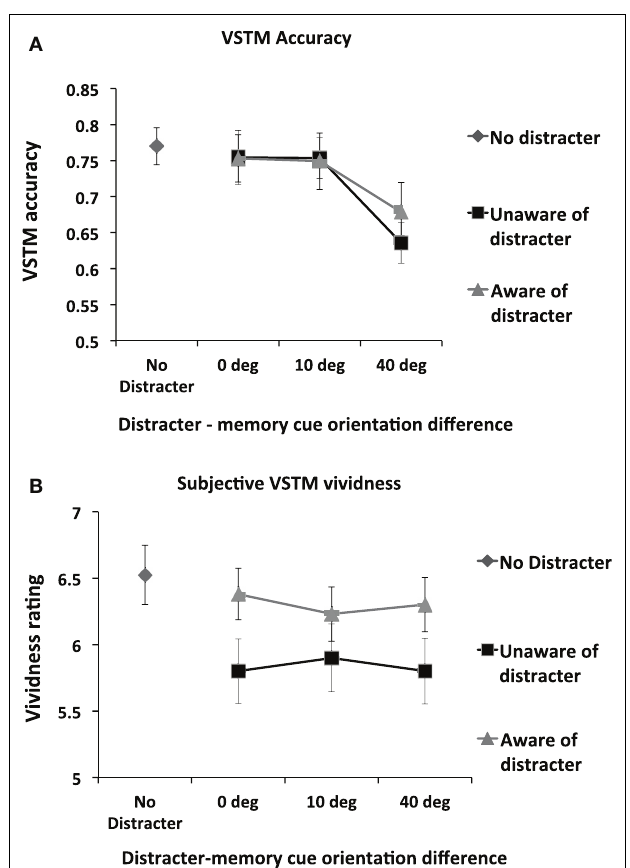
FIGURE 3 | (A) Mean ( n = 14) objective memory accuracy in theVSTM task as a function of the distracter orientation and visibility.The impact of the visual distracter onVSTM accuracy was determined by the orientation difference between the memory cue and the distracter; a reduction in accuracy was observed only when this difference was 40˚. Distracter visibility did not influence this effect; a disruptive effect was observed regardless of whether participants rated the distracter to be visible. Error bars indicate ± 1 SEM. (B) Mean ( n = 14) subjectiveVSTM vividness as a function of the distracter orientation and visibility.The impact of the visual distracter on subjective vividness of the memory representation was not modulated by the orientation of the distracter. Rather, all distracter orientations reduced vividness ratings, but only when the visual distracter was judged not to be visible.Thus a double dissociation in the effects of distracters onVSTM accuracy and subjective vividness was found: the impact onVSTM accuracy depends on the orientation difference between the memory cue and the distracter but not distracter visibility; the impact on subjective vividness of the memory item was determined by distracter visibility but not by orientation difference. (SD = 0.17) and 0.77 (SD = 0.10) for false alarm and correct rejection trials, respectively. For vividness, the mean ratings were 6.15 (SD = 1.20) and 6.50 (SD = 0.84) for false alarm and correct rejection trials,